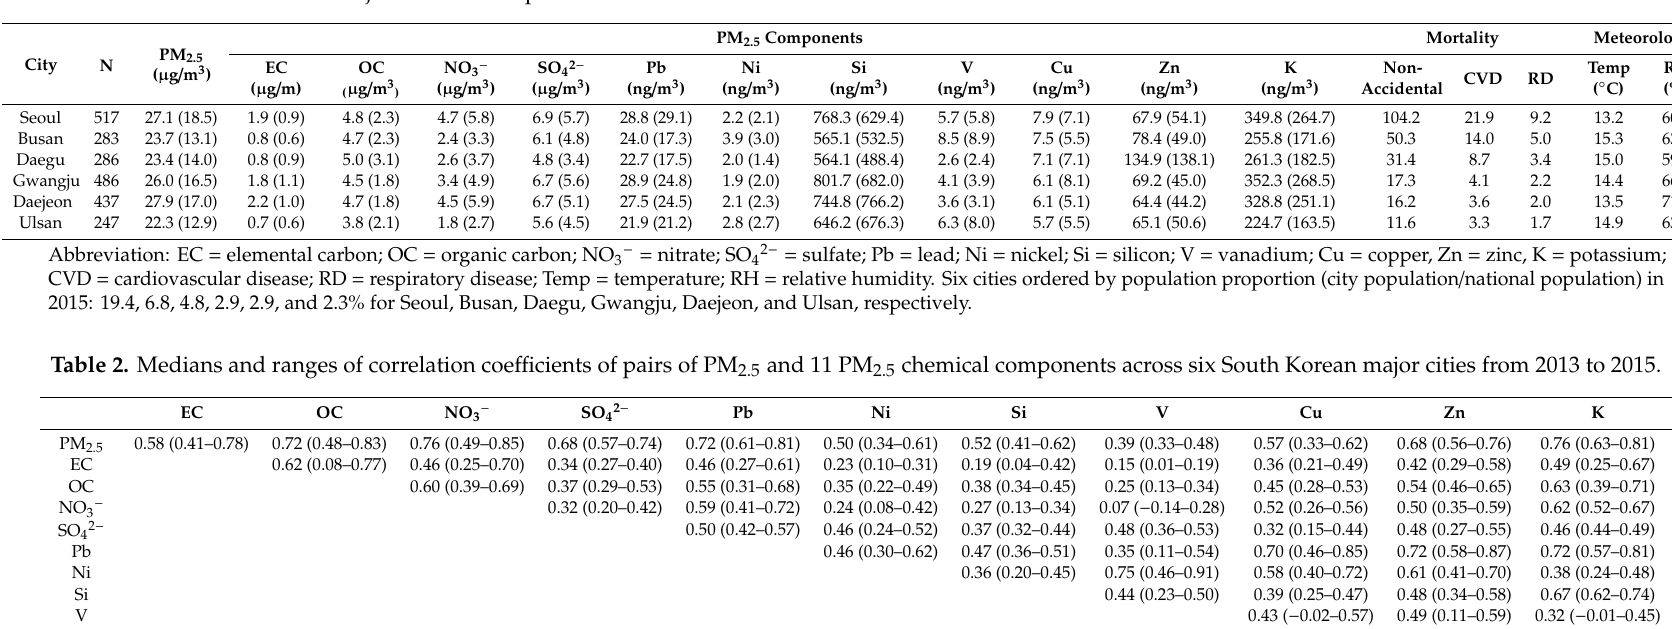
Table 1. Means and standard deviation of daily concentrations of PM 2.5 and 11 PM 2.5 chemical components, and means of daily mortality and weather variables in each of the six South Korean major cities for the period from 2013 to 2015.